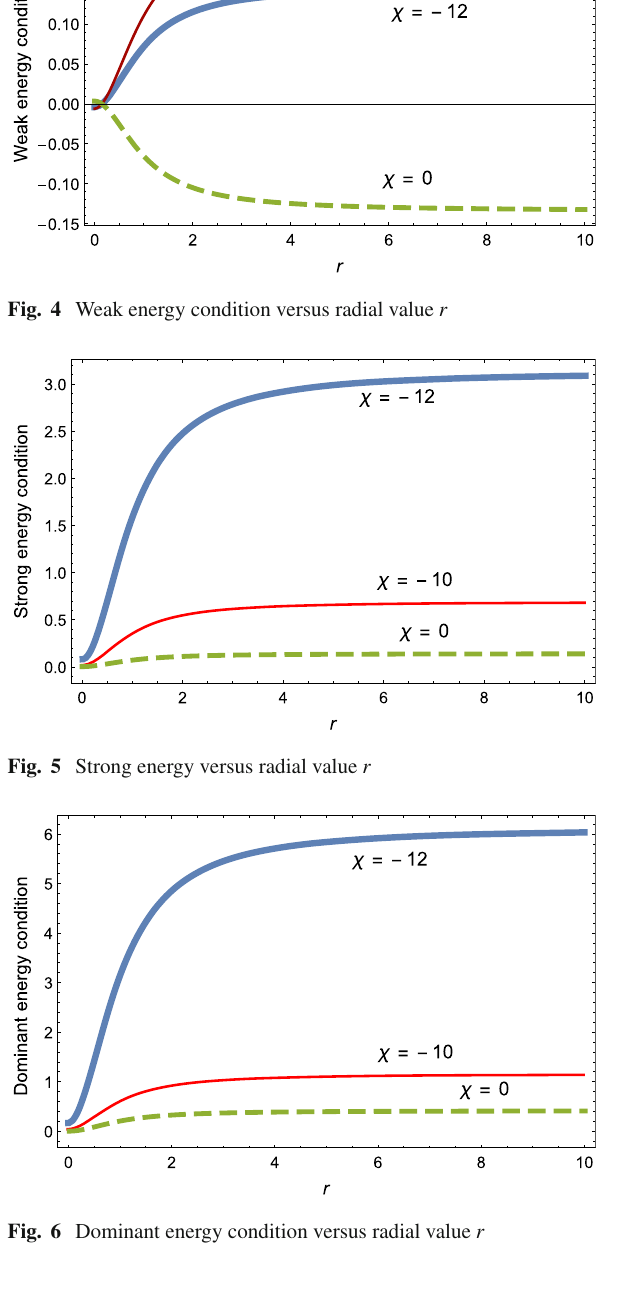
counterpart. In summary, the f ( R , T ) case displays more pleasing physical behavior than the Einstein case.